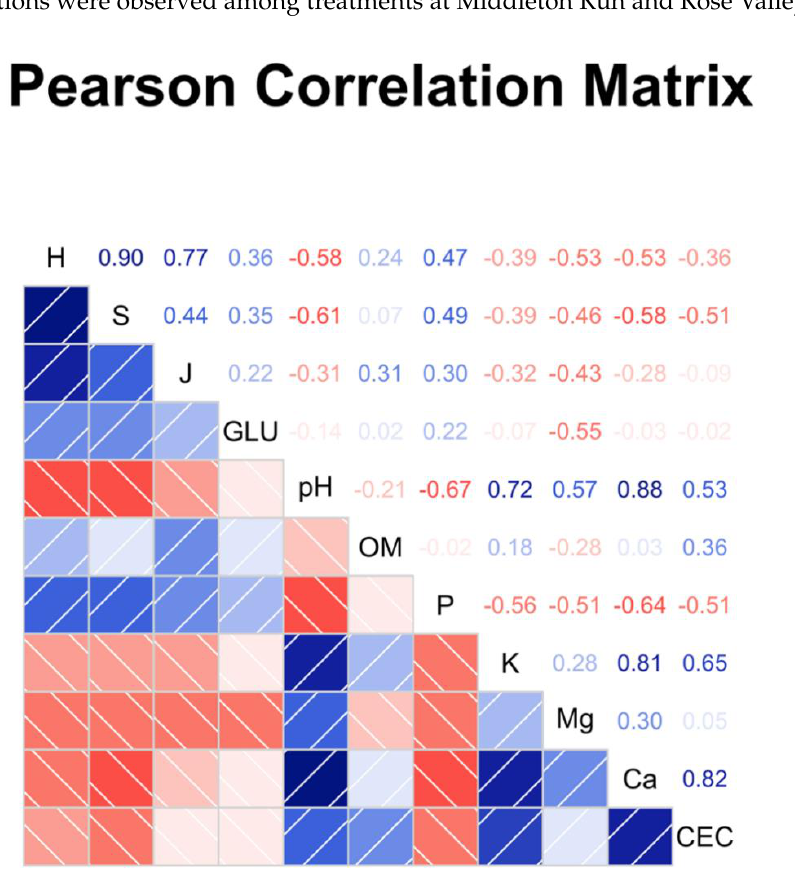
Figure 7. Pearson correlation matrix of plant diversity metrics (collected 2020), soil chemistry (collected 2020), beta-glucosidase enzyme activity (collected 2019), and FAME microbial biomarkers (collected 2019). Abbreviations: H = plant Shannon–Wiener diversity index, S = plant species richness, J = plant species evenness, GLU = beta-glucosidase enzyme activity, pH = 1:1 soil pH, P = soil phosphorus concentration, K = soil potassium concentration, Mg = soil magnesium concentration, Ca = soil calcium concentration, and CEC = soil cation exchange capacity.